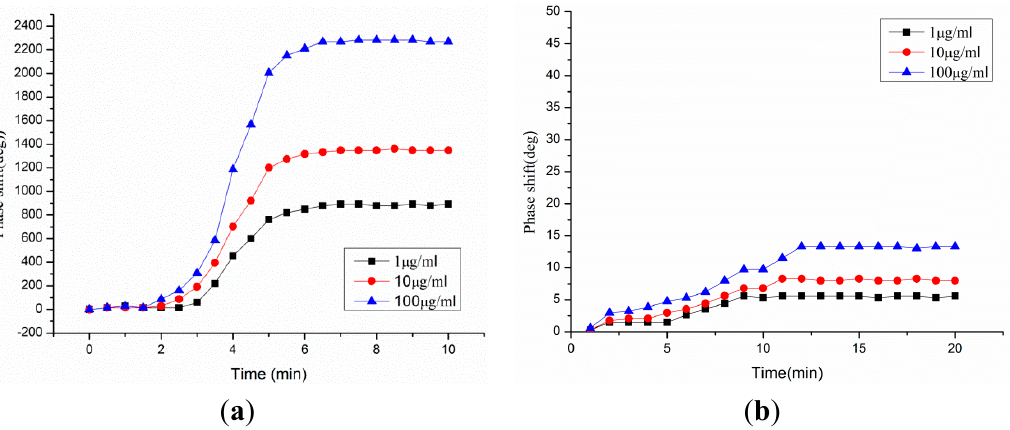
Figure 13. Phase responses of ( a ) the R4 and ( b ) R3 reflection peaks against rabbit IgG concentrations.